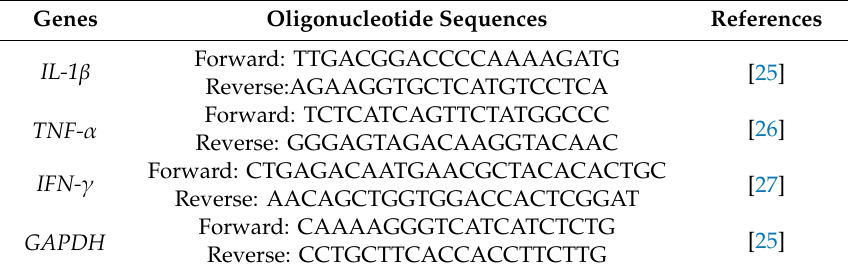
Table 2. Oligonucleotide primers used for quantitative polymerase chain reaction (PCR) analysis. Genes Oligonucleotide